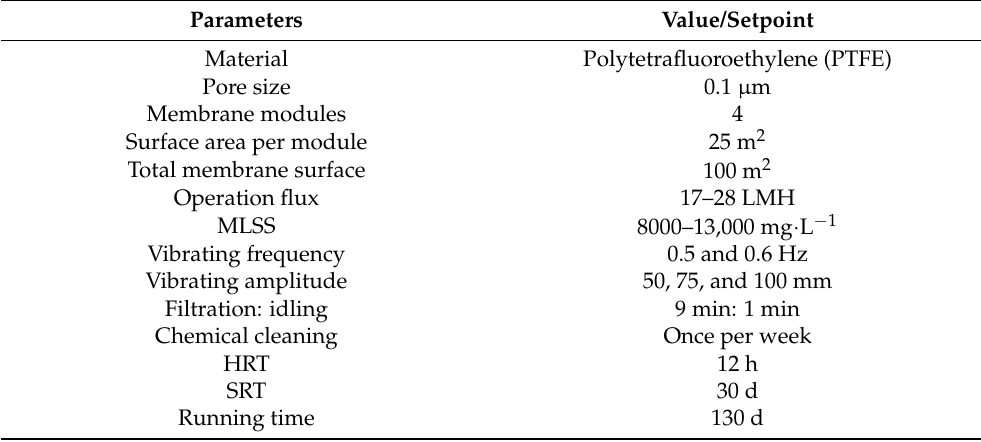
Table 1. The membrane characteristics and operation conditions of the LEP-N-MBR